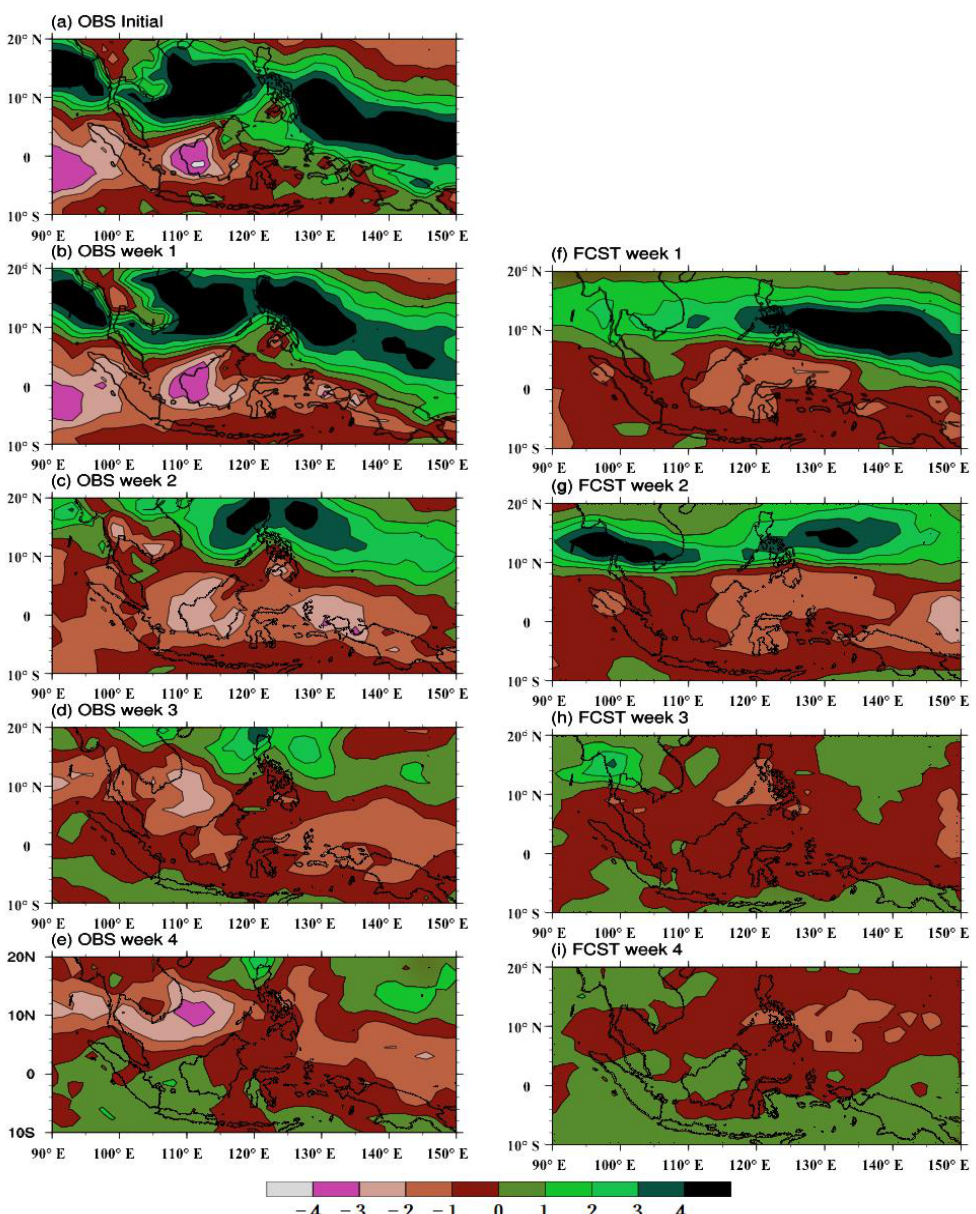
Figure 9. Composite observation (left panels) and (median MME) forecast precipitation anomalies (mm / day) from initial conditions of BSISO1 phase 5. ( a ) Observed initial conditions, ( b – e ) observed average for weeks 1–4, and ( f – i ) forecast average for weeks 1 – 4.